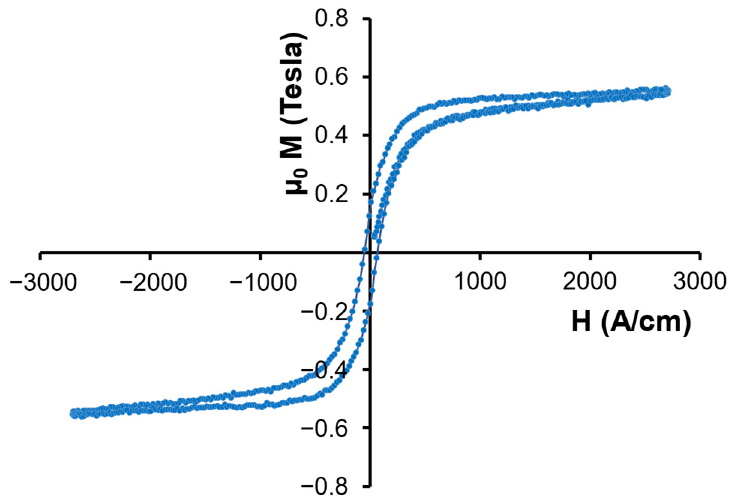
Figure 4. Magnetic hysteresis loop of the sample in its original condition.